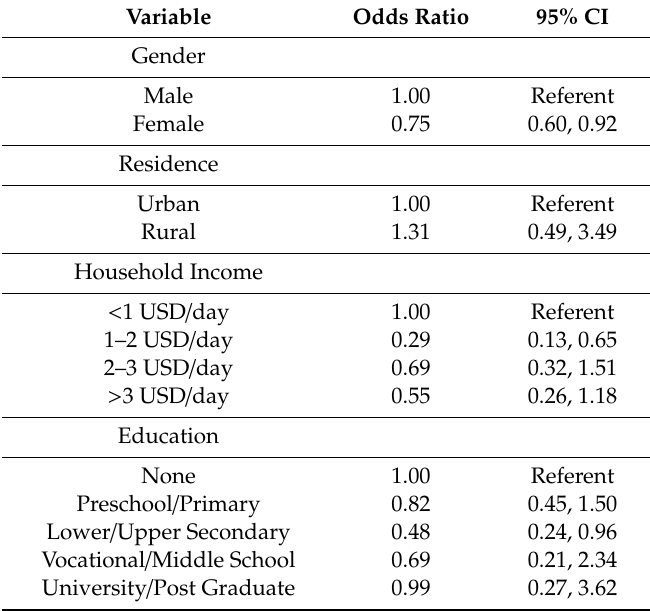
Table 2. Associations between demographic variables and self-reported lifetime history of tuberculosis in 9043 adults (ages 15 and older) of the 2012 National Adult Tobacco Survey of Lao PDR. Variable Odds Ratio 95% CI Gender Male 1.00 Referent Female 0.75 0.60, 0.92 Residence Urban 1.00 Referent Rural 1.31 0.49,